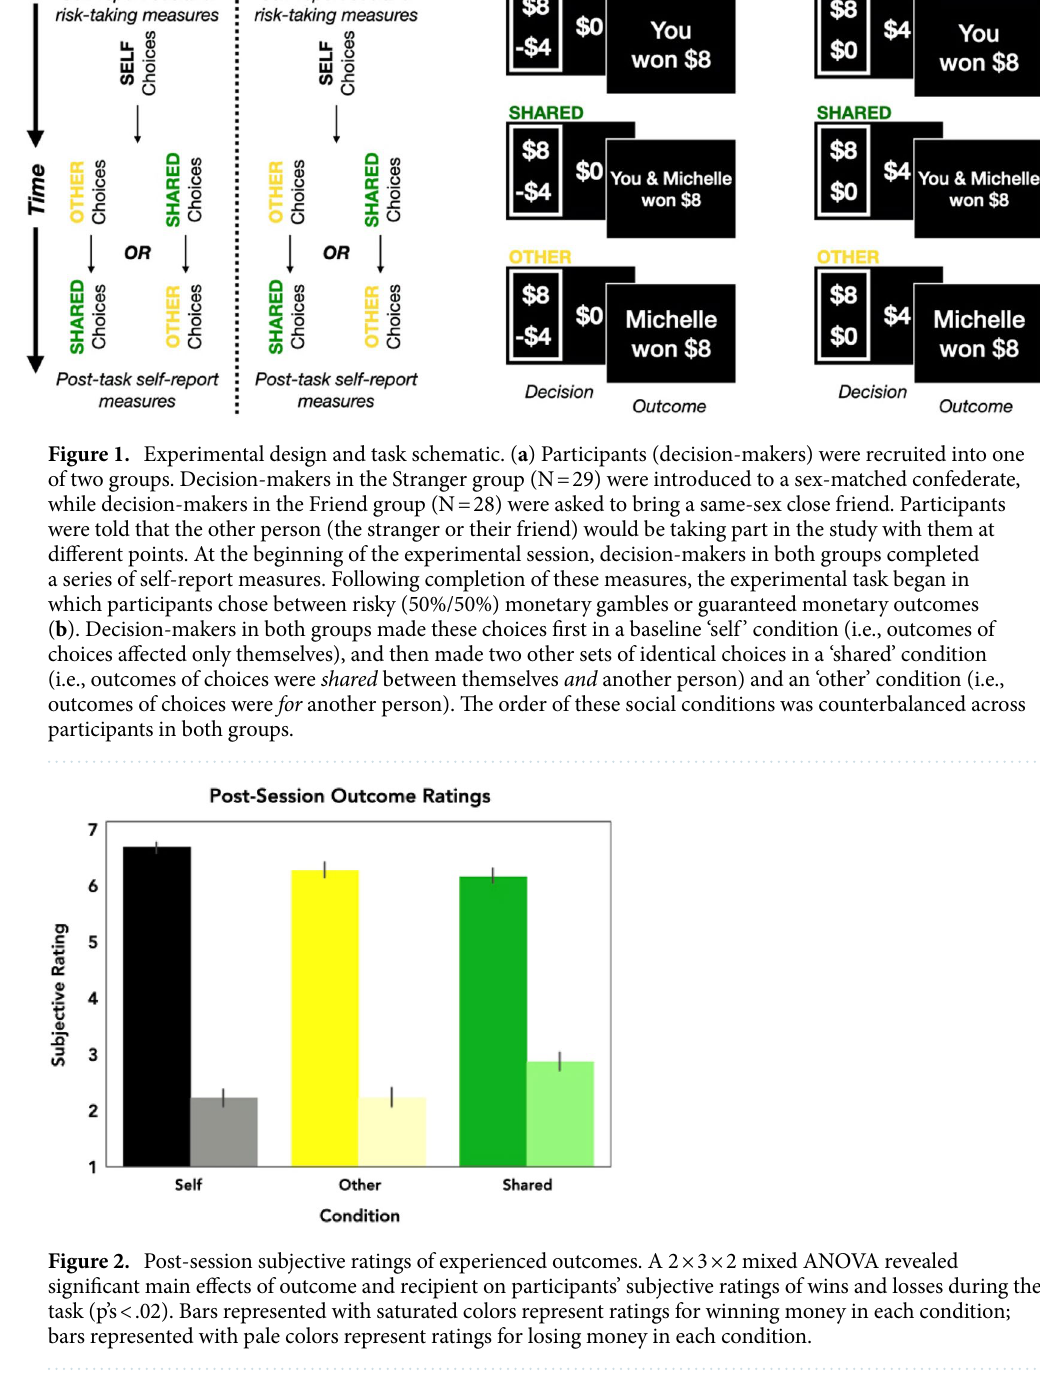
more excited when they were involved in the outcome as compared to only playing for their partner (shared vs.